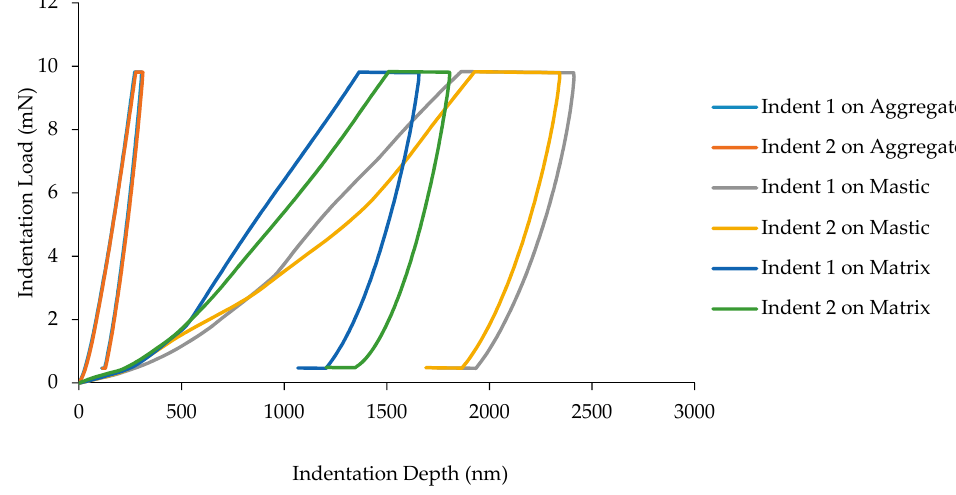
Figure 8. Load-displacement curve for all phases in AC with hydrated lime.